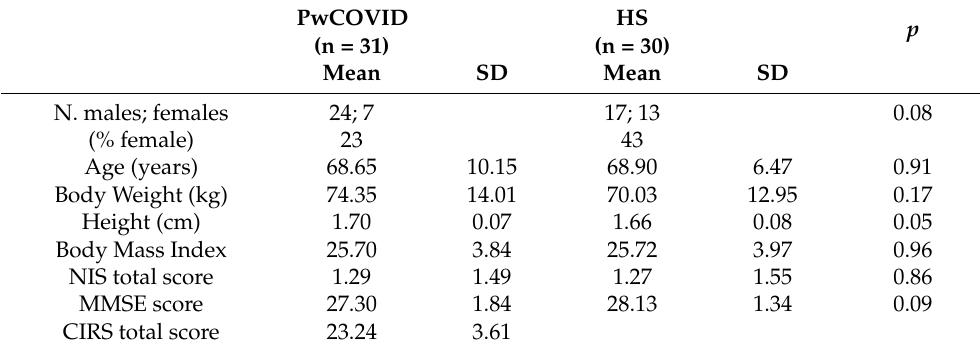
Table 1. Characteristics of patients and healthy control: comparison between